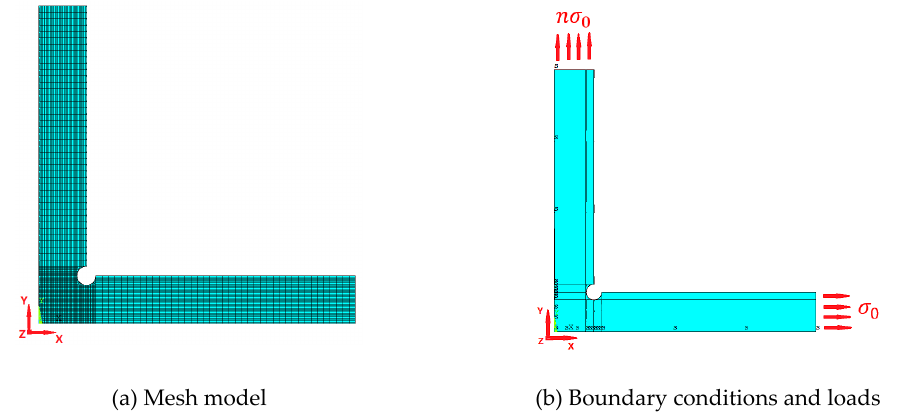
Figure 5. Illustration of the finite element model for specimen type D.